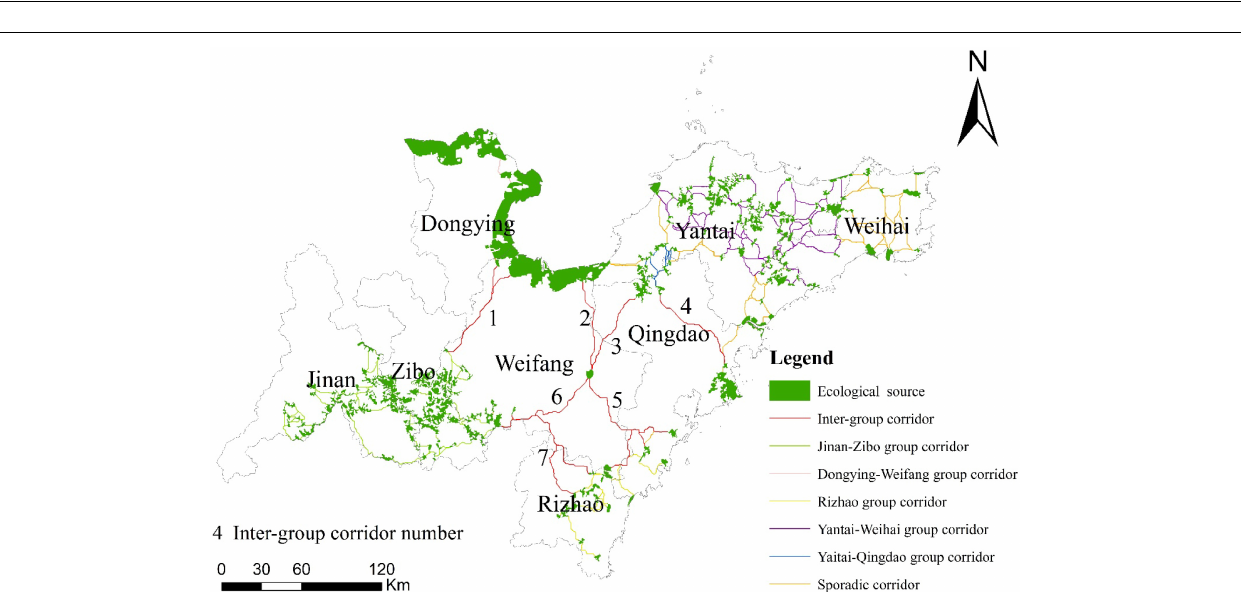
FIGURE 6 | Spatial differentiation of ecological resistance surface in Shandong Peninsula urban agglomeration.